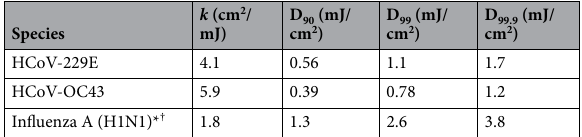
Table 2. Estimated k , D 99 , and D 99.9 values for exposure to 222 nm far-UVC light for alphacoronavirus HCoV- 229E, betacoronavirus HCoV-OC43, and influenza A (H1N1). * D 99 , and D 99.9 values for influenza A (H1N1) denote extrapolated values, as these doses were not used during testing 23 . † Our previous work with H1N1 utilized the fluorescent focus assay 23 , while the current work with coronaviruses used the TCID 50 assay.